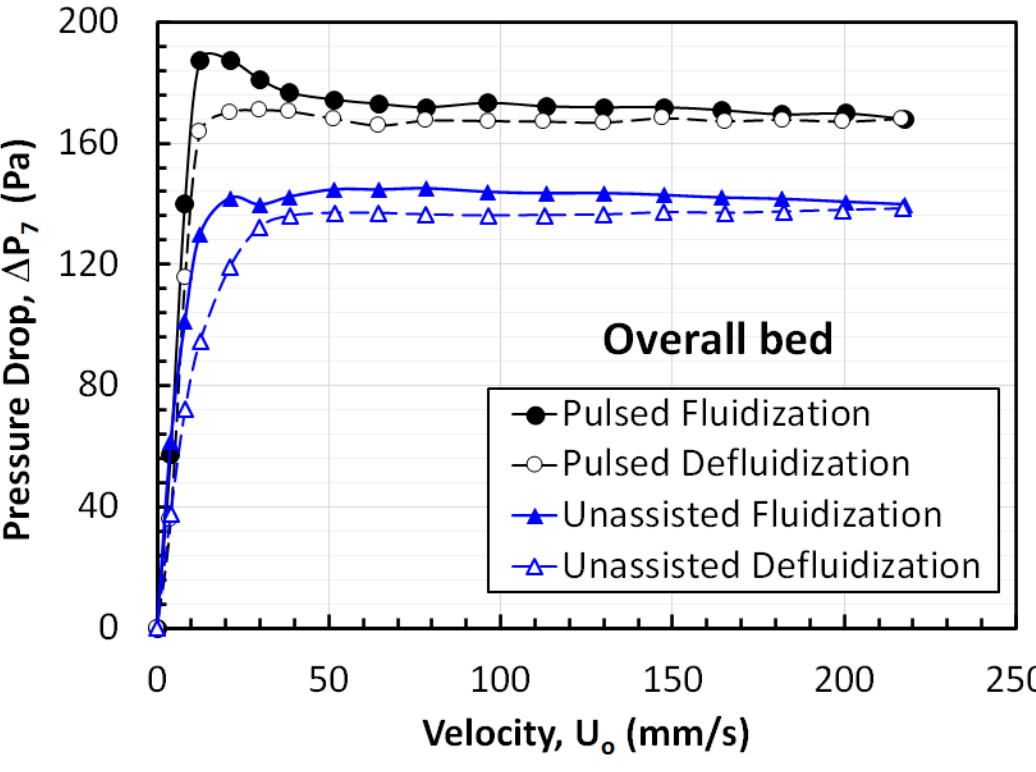
Figure 12. Effect of the velocity on the global pressure drop profiles for unassisted and pulsed fluidized beds during fluidization and defluidization.